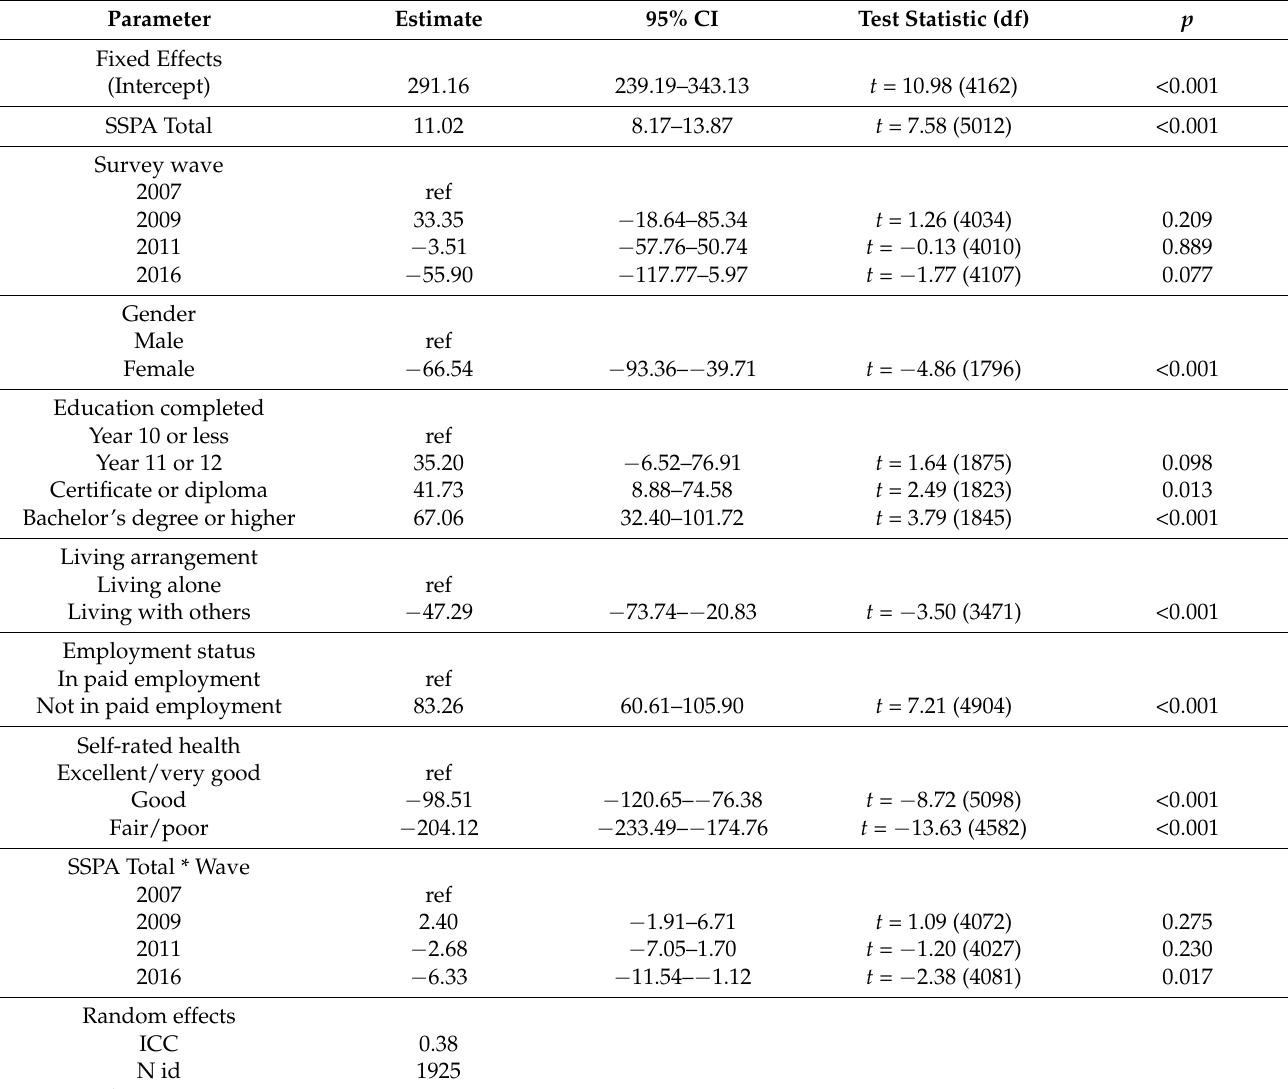
Table 2. Associations between physical activity and social support for physical activity (SSPA) over 9